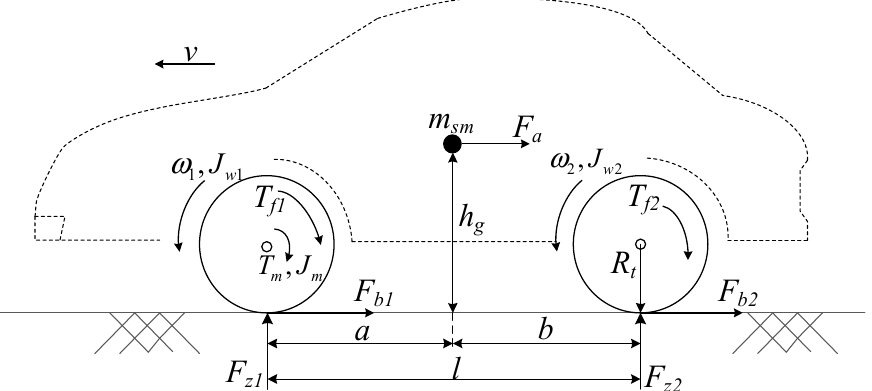
Figure 3. The reference vehicle force analysis curve. Table 1. Main parameters used in